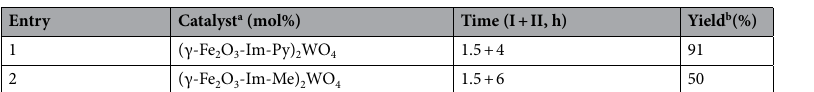
Table 6. The effect of different catalysts in the synthesis of 2-amino-3-cyano-4 H -chromene from benzyl alcohol. a Amount of the catalyst (5 mol%, 142 mg) is based on W content and relative to benzyl